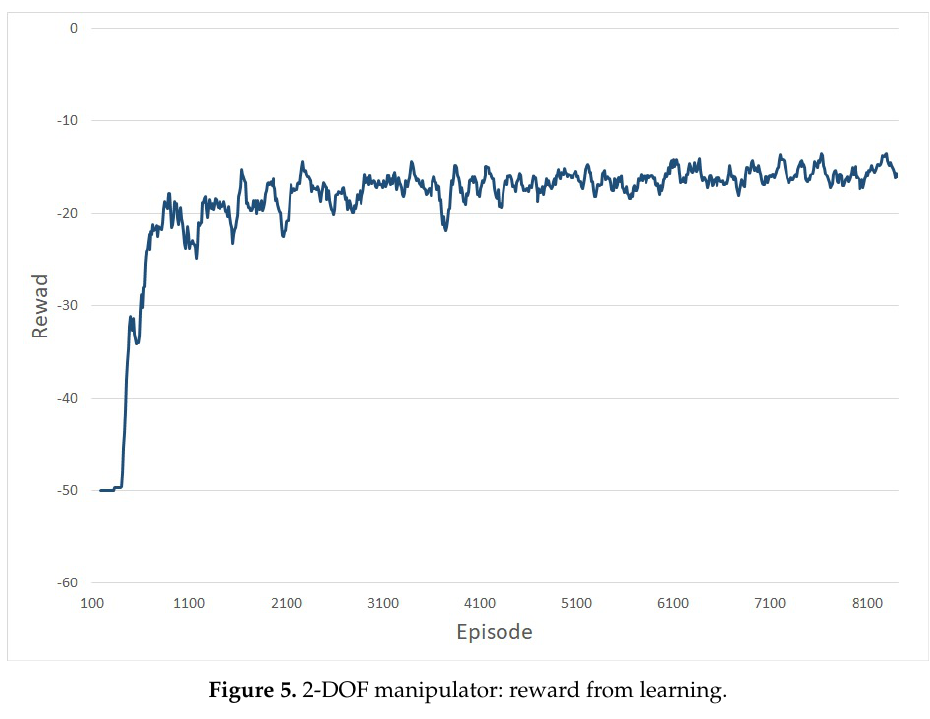
Figure 5. 2-DOF manipulator: reward from learning.